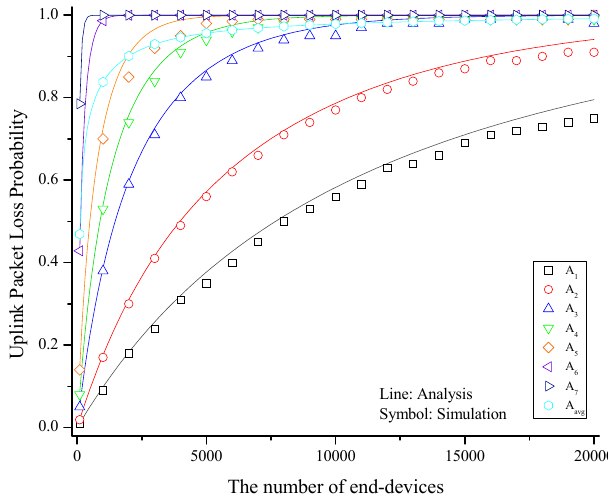
Figure 3. Packet Loss Probability as a function of the number of